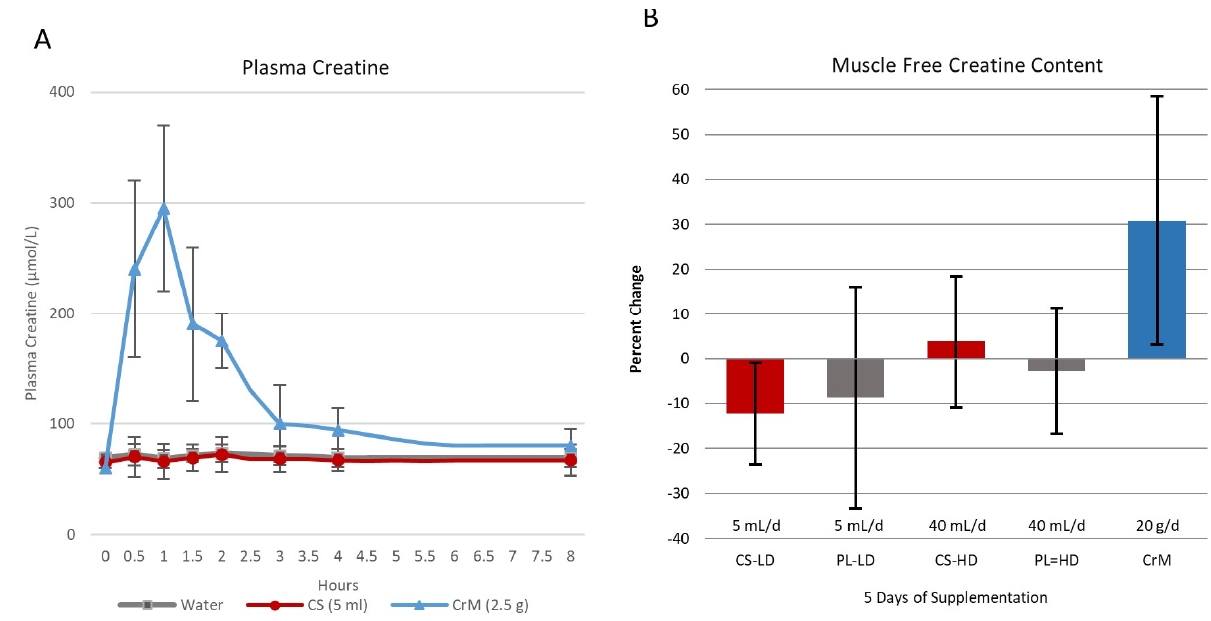
Figure 14. Changes in plasma creatine levels after oral ingestion of water, 5 mL of creatine serum (CS) purportedly providing 2.5 g of CrM, and 2.5 g of CrM in solution ( A ) [26] and 5 days of 5 mL of CS purportedly providing 2.5 g of creatine (CS-LD), 5 mL of a flavored placebo (PL-LD), 8 × 5 mL of CS (CS-HD) purportedly providing 20 g/day of creatine, 8 × 5 mL of flavored placebo (PL-HD), or 4 × 5 g/day of CrM ( B ) [26], Adapted from Harris et al. [38] and Kreider et al.